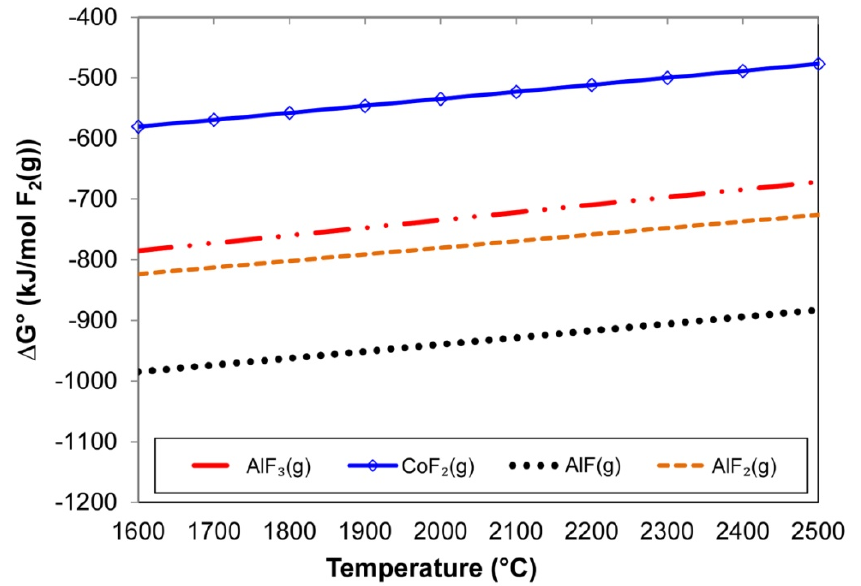
Figure 6. Standard Gibbs free energy for metal vapour and F 2 gas reactions of Al and Co as calculated in FactSage 7.3 [31].